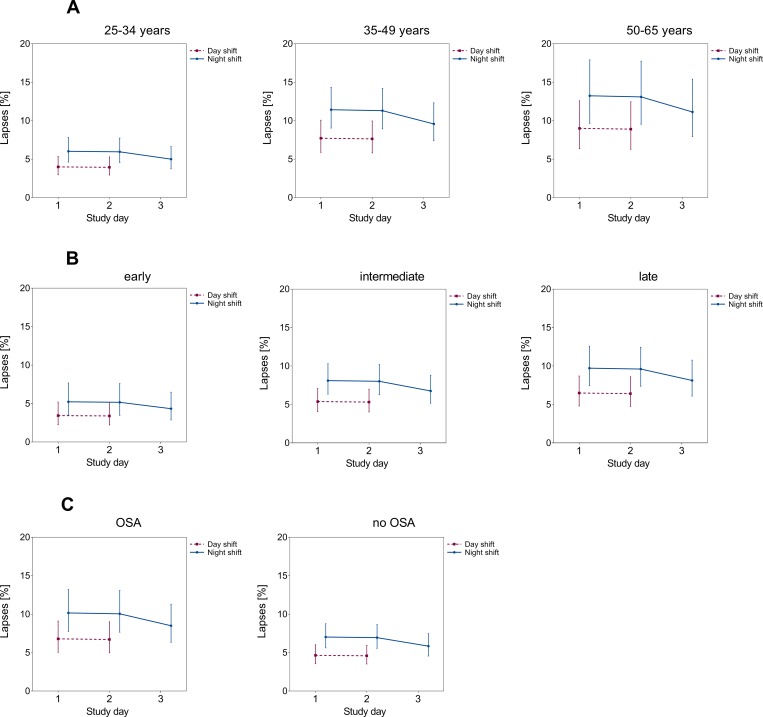
Lapses (%) and associated 95% confidence intervals according to study day: LS-means stratified by age group (panels A, adjusted for chronotype, OSA, season), chronotype (panels B, adjusted for age, OSA, season), and presence of mild to moderate OSA (panels C, adjusted for age, chronotype, season).